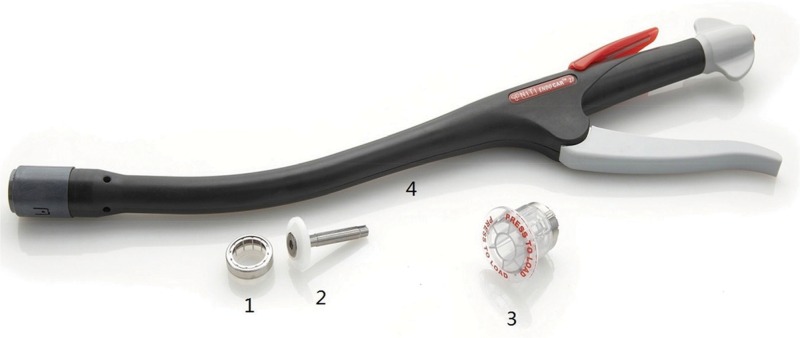
The structure of the NiTi compression anastomosis ring (NiTi CAR 27). It consists of 1. A nitinol mental compression ring, 2. an anvil, 3. a ring loader, and 4. a firing device.